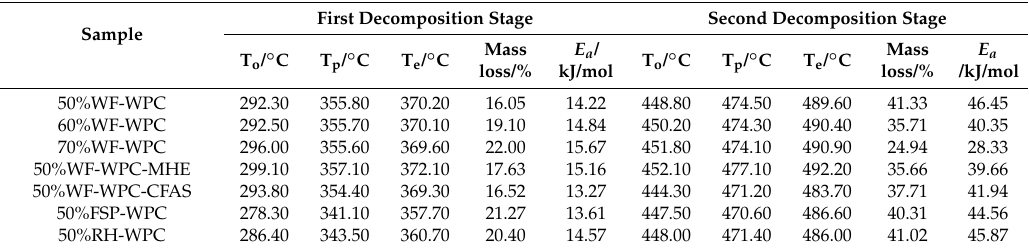
Figure 1. TGA ( a , b ) and DTG ( c , d ) curves for WPCs. Table 2. Characteristic data of the WPCs using thermogravimetric analysis.